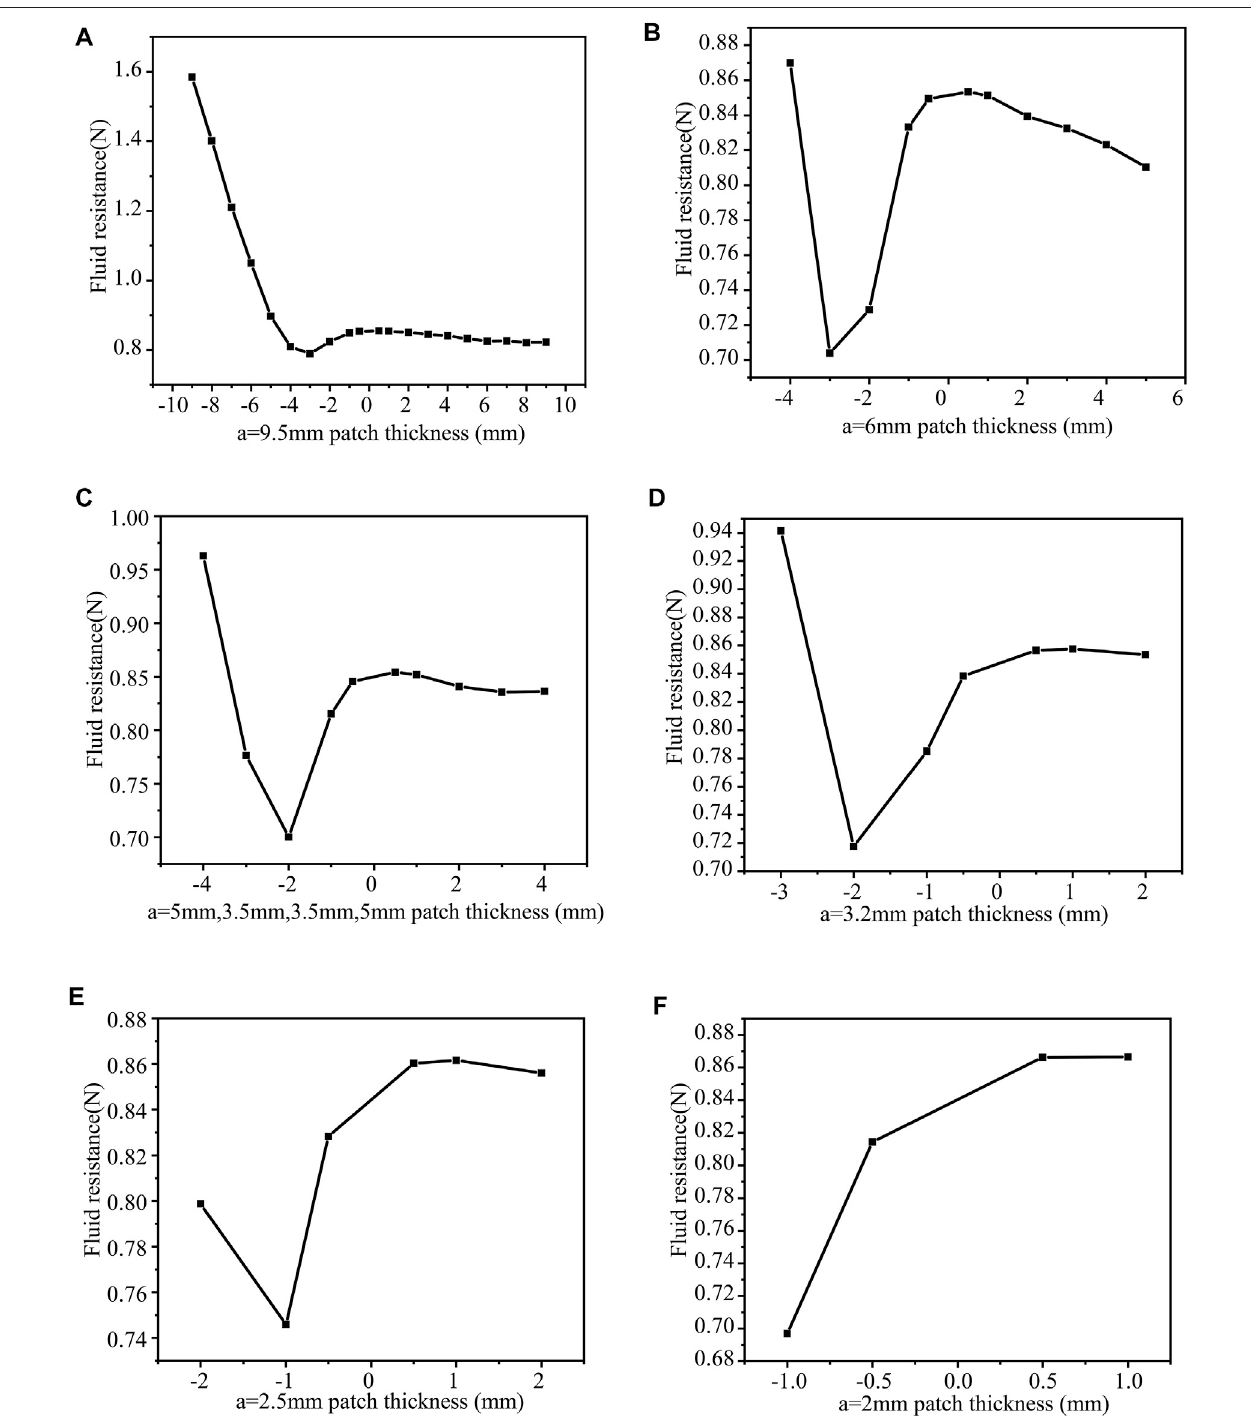
FIGURE11| b=1 mm,thenumberofpatchesandthedragforceunderdifferentthicknesspatches (A) a=9.5mm; (B) a=6mm (C) a=5mm (D) a=3.2mm (E) a = 2.5 mm (F) a = 2 mm.